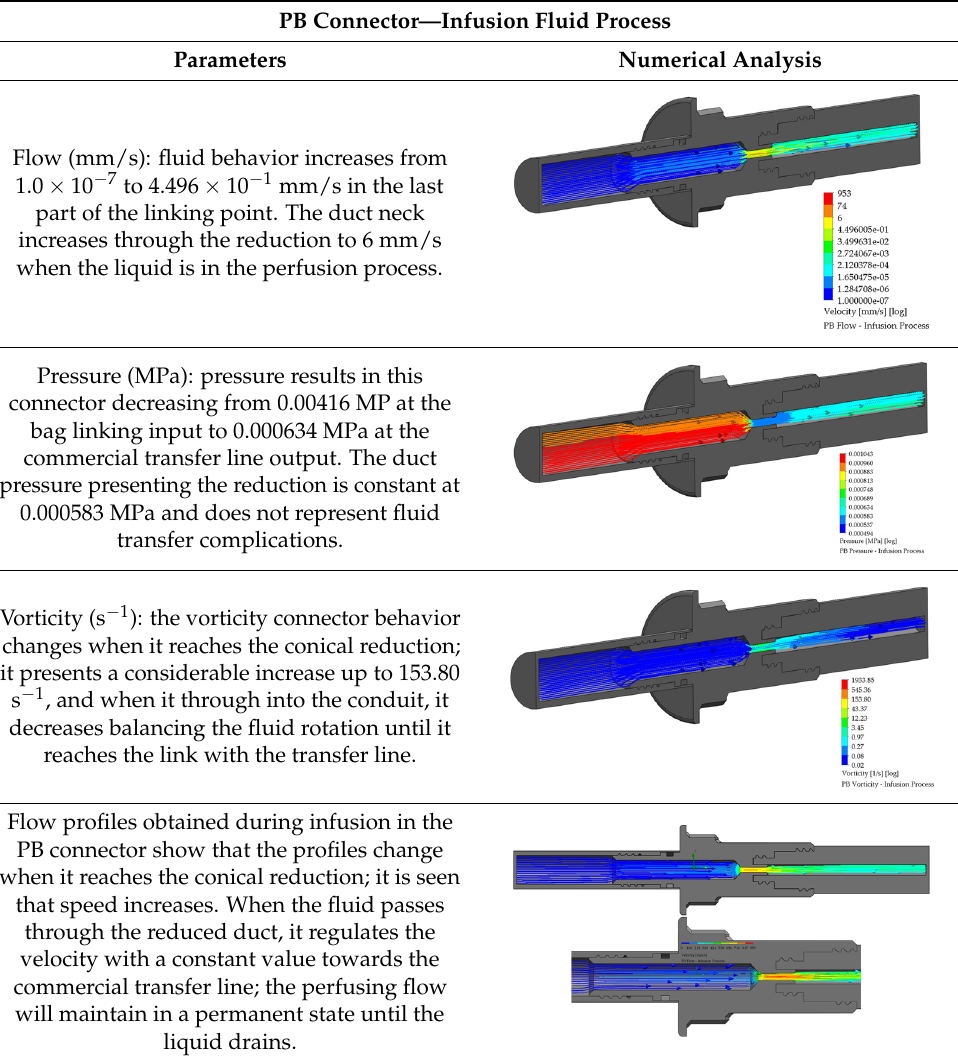
Table 6. Flow, pressure, and vorticity numerical analysis for PB connector—fluid draining pro- cess.